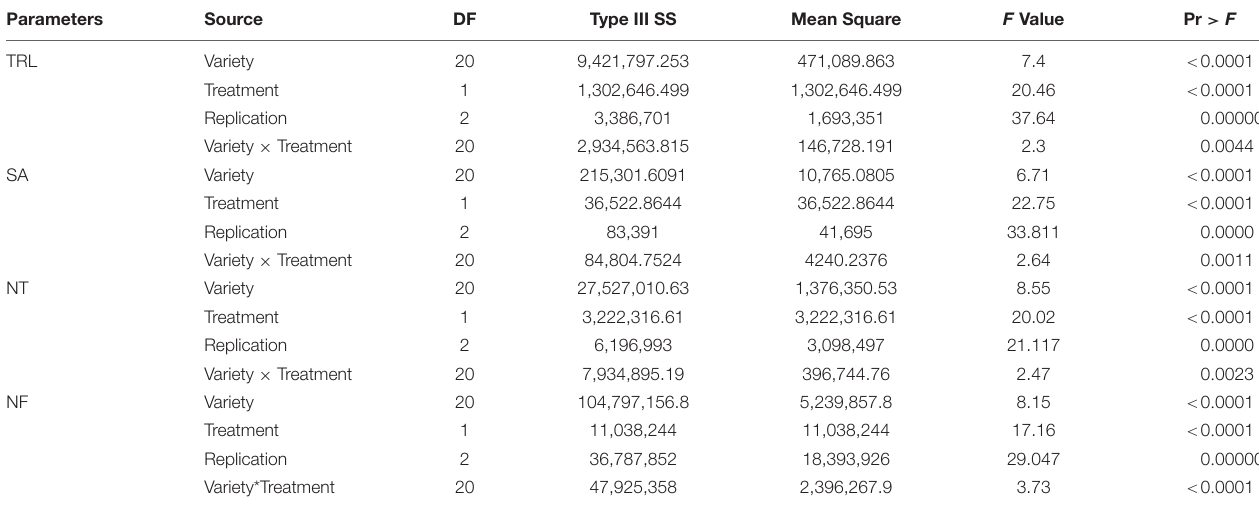
TABLE 1 | Analysis of variance (ANOVA) of the shoot and root parameters among 21 soybean cultivars.